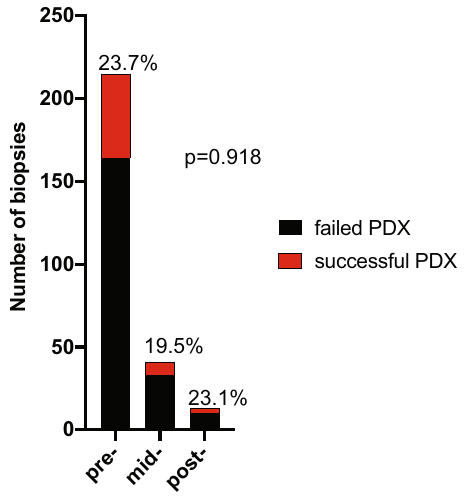
Fig. 2 PDX establishment from pre-, mid-, and post-NACT biopsies. The number of patient biopsies obtained is displayed and the percentage of successful PDXs generated from each treatment stage is written atop each bar. The p value was computed by Fisher ’ s exact